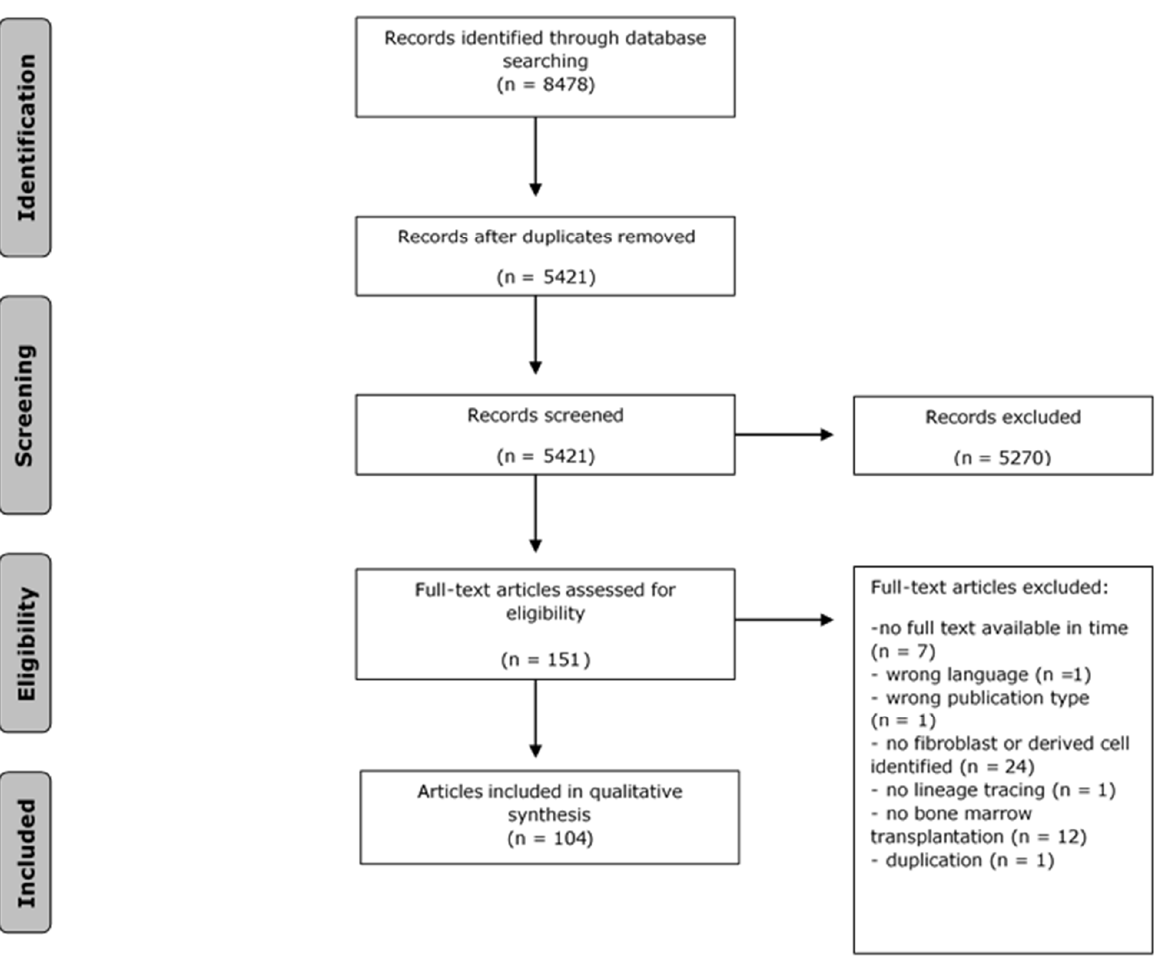
Figure 1. Flow chart of the literature search and selection process.